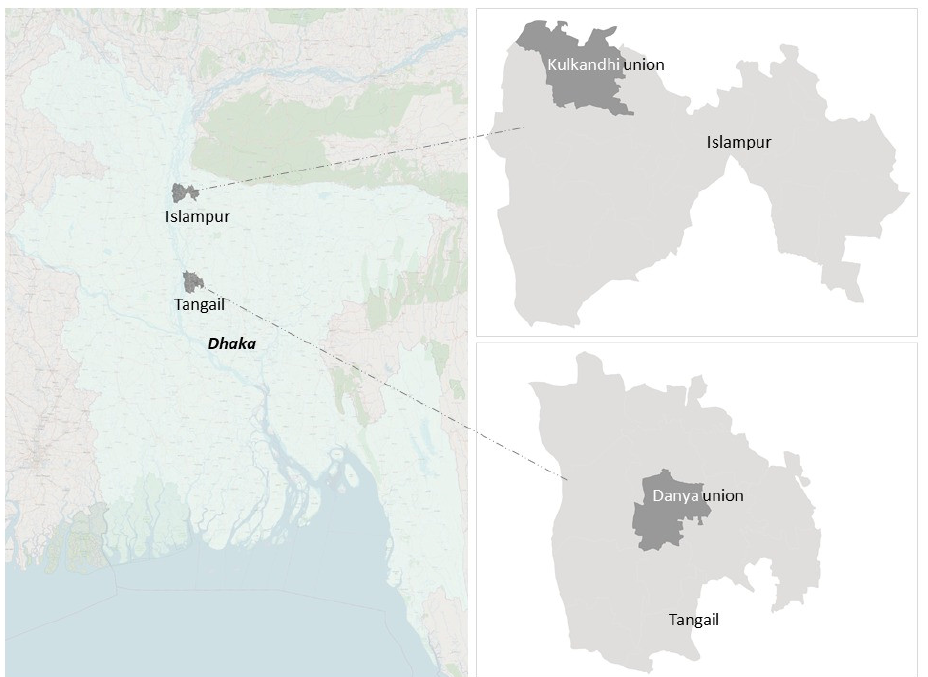
Figure 1. Location map of the study areas: Danya Union in Tangail Sadar Upazila, Tangail District, and Kulkandi Union in Islampur Upazila, Jamalpu District (background image source: Openstreet). Union, Upazila, and District represent, respectively, the fourth, third, and second administrative layers of the government of Bangladesh.